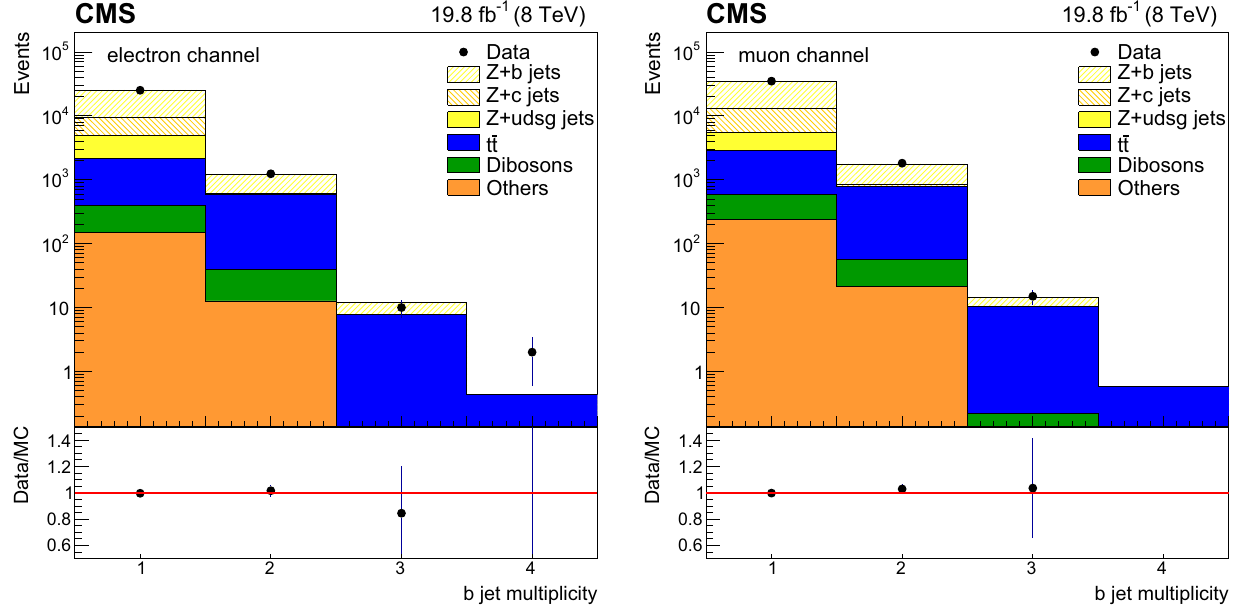
mates need to be rescaled by the ratio of the